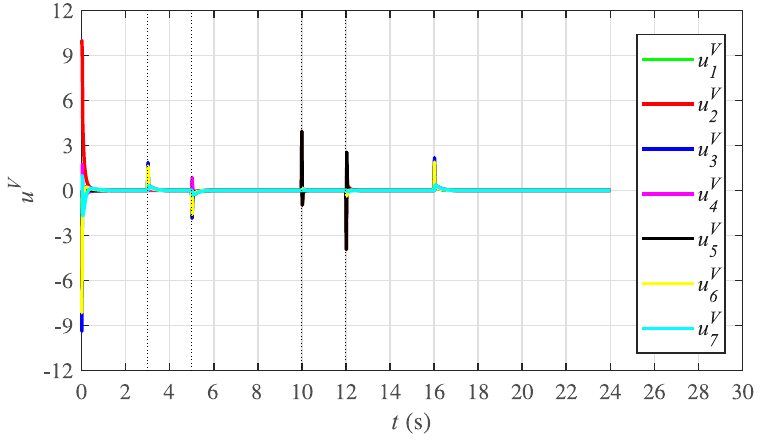
Fig 31. Voltage regulation control efforts under case